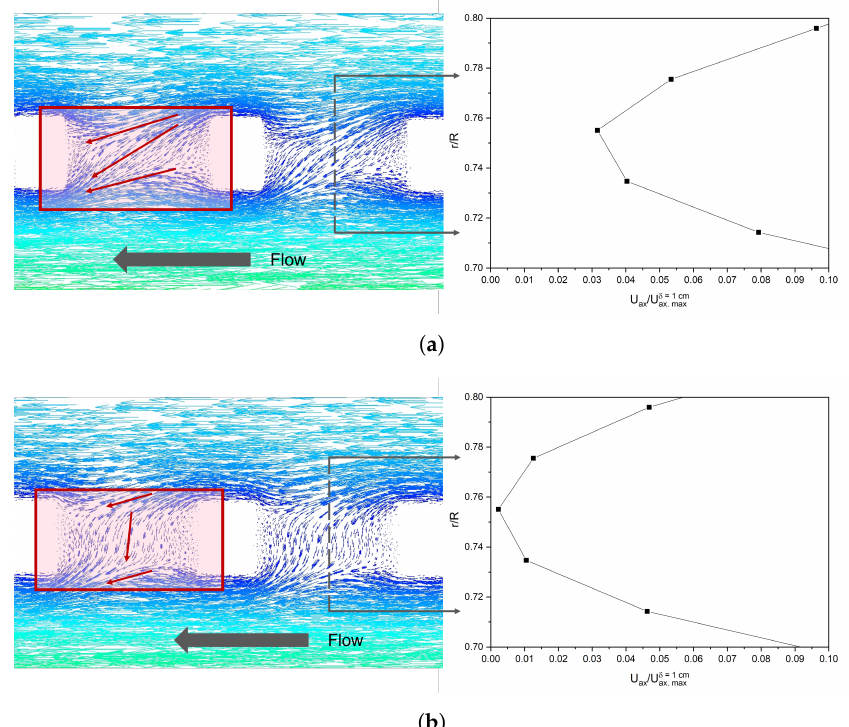
Figure 11. Velocity contour plots and axial velocity profiles in laminar regime with δ equal to 1 cm and w 0.6 cm for ( a ) WME and ( b ) EME.